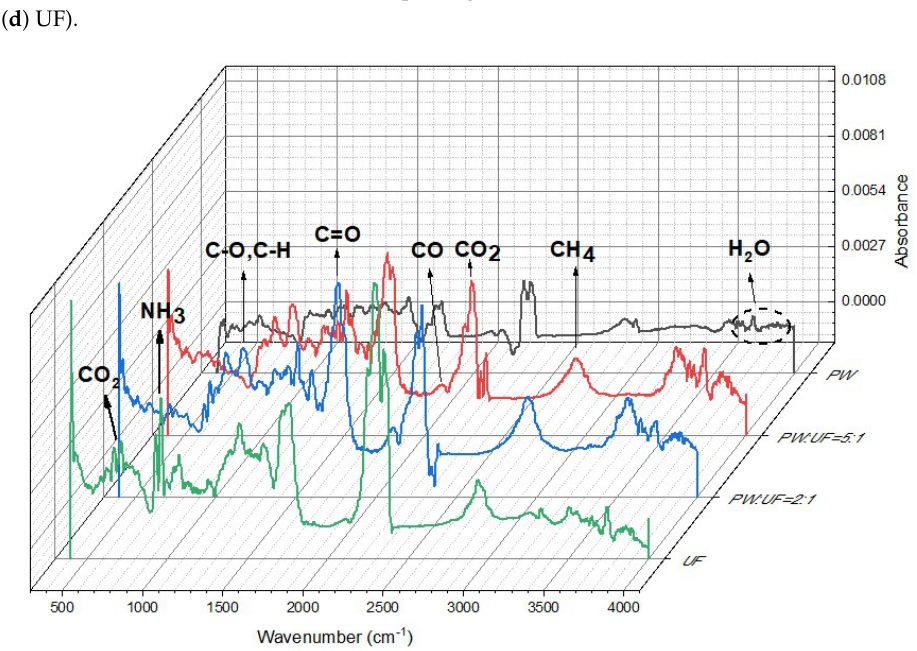
Figure 4. FTIR spectra of gaseous products obtained at the maximum weight loss peak.